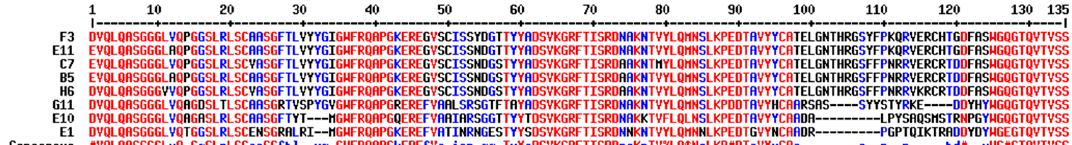
Figure 1. Protein sequences of the eight representative sdAb that were produced and evaluated. Sequences are presented using one-letter amino acid abbreviations. Multalin was used to generate the alignment; red denotes high homology positions while lower homology is in blue [23]. Numbering is sequential based on the F3 sequence. Using this numbering, CDR 1 is from 26 to 33, CDR 2 is from 51 to 58, and CDR3 is from 97 to 124.